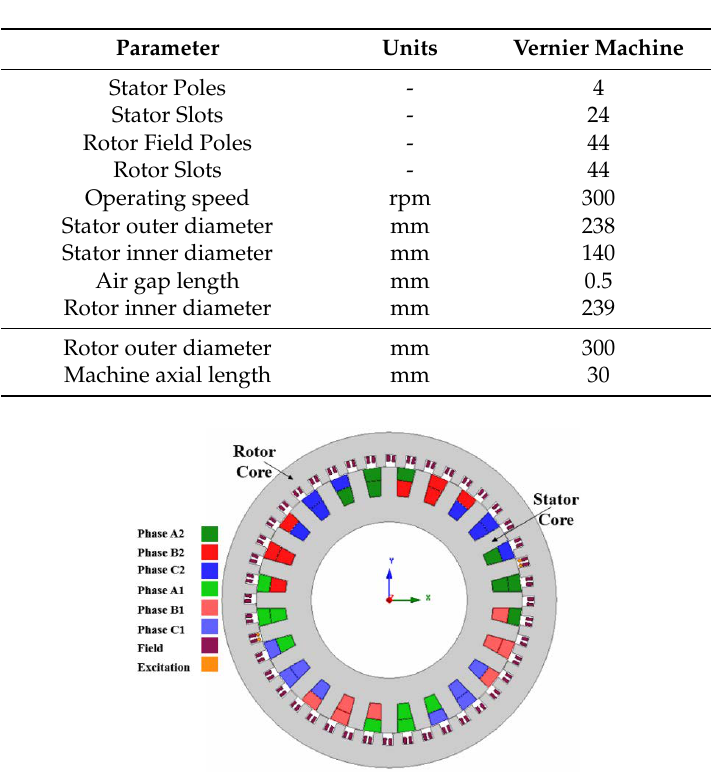
Table 1. Design parameters of the basic model of the brushless wound-rotor vernier machine (BL-WRVM).